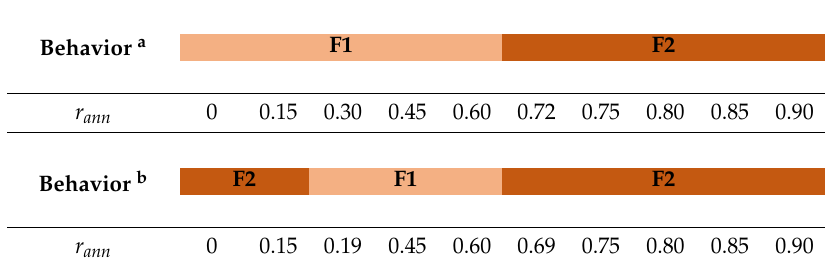
Table 3. Summary of the leaching-tubing-like systems behavior with the vibration of r ann from 0 to 0.90.